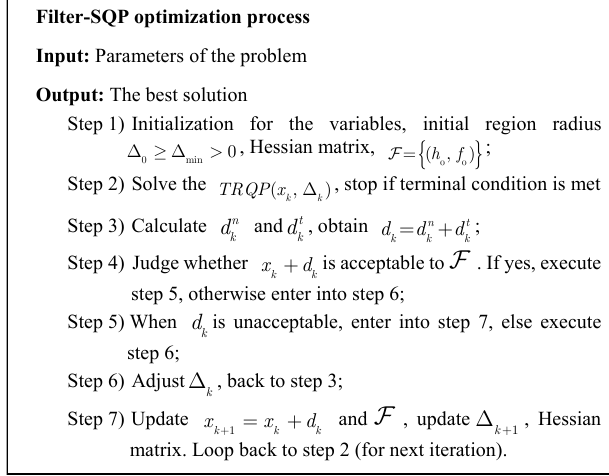
Figure 2. Pseudo code of filter- sequential quadratic programming (SQP) .